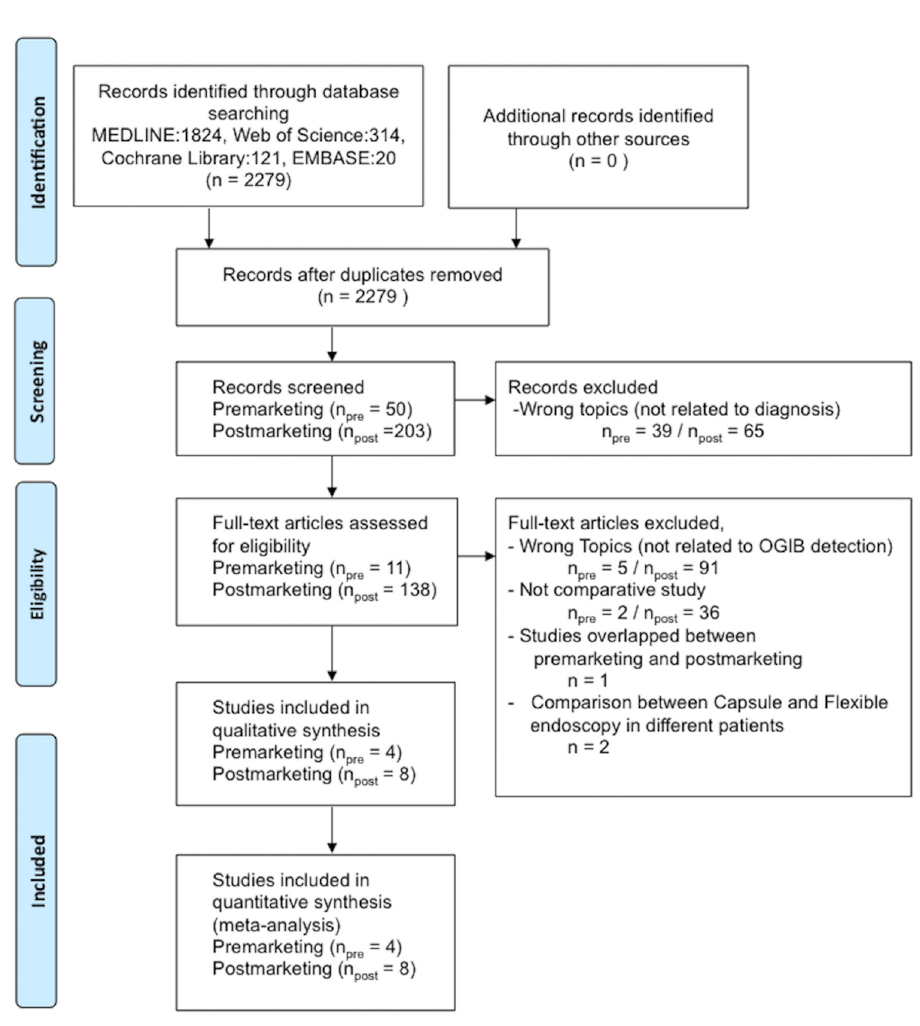
Fig 2. Flow chart of study selection for the